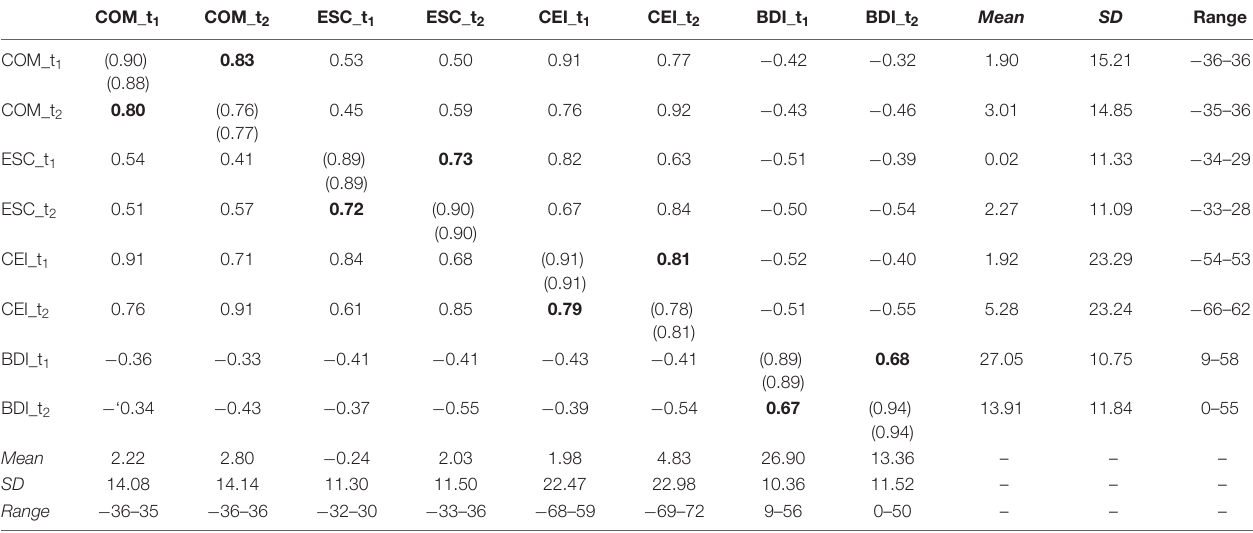
TABLE 1 | Descriptive statistics and correlation coefficients between t 1 - and t 2 -scores of all